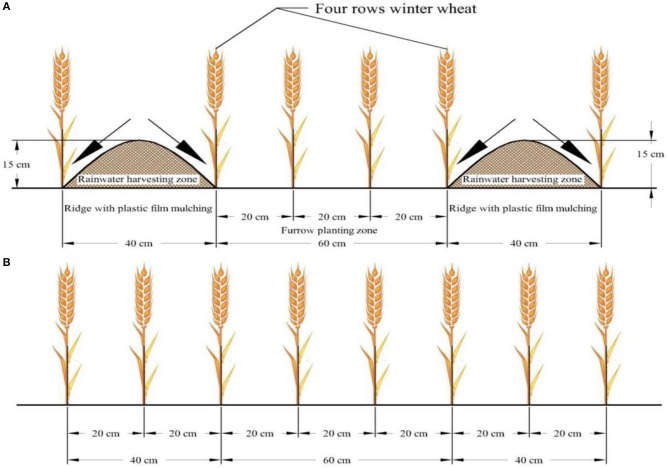
A Schematic diagram of the field layout showing (A) RF system (Ridge covered with plastic film mulch) and (B) TF (traditional flat planting).